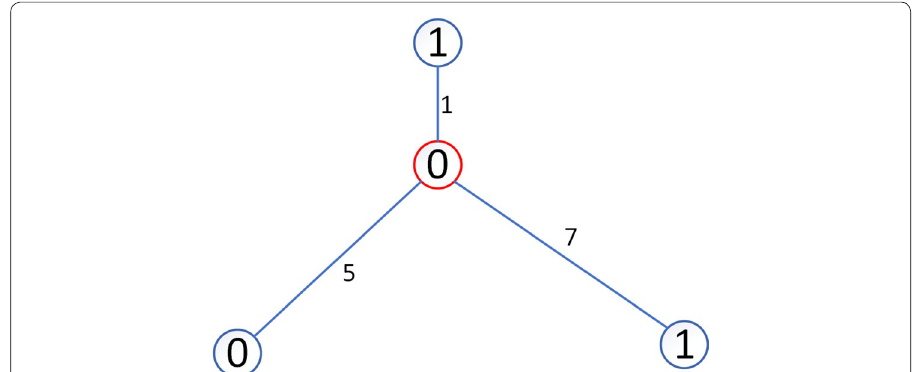
Fig. 1 Illustration of filtering algorithm in 2-dimentional space